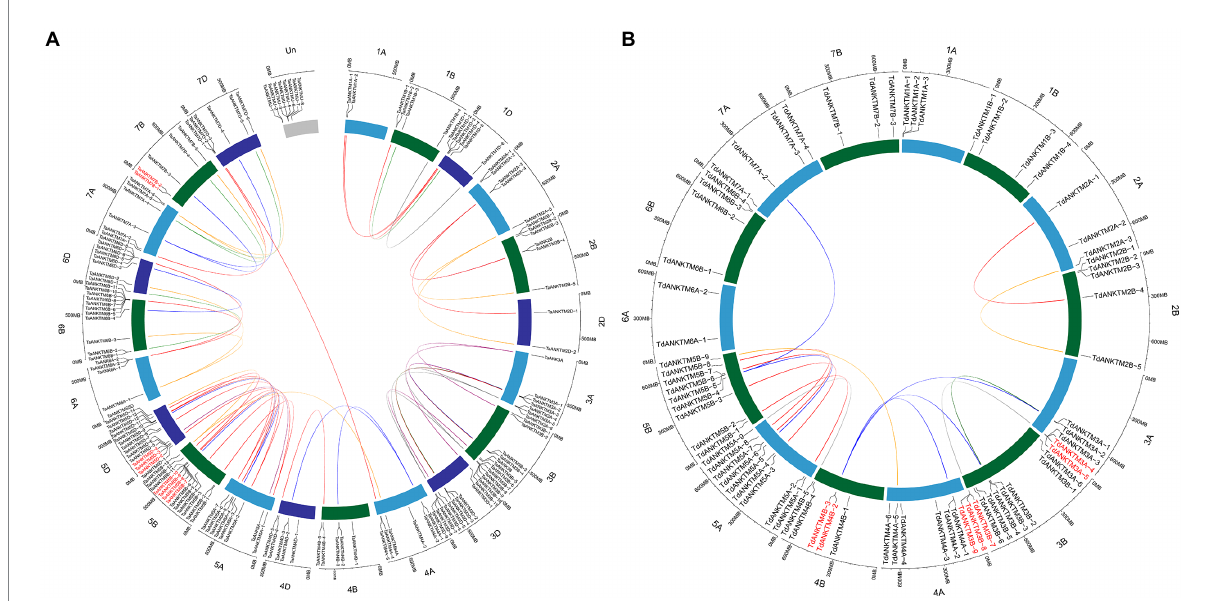
FIGURE 2 Homologous gene pairs, tandem duplication and location of ANKTM genes in wheat and T. dicoccoides genomes. All ANKTM genes were mapped to their respective loci in the wheat (A) and T. dicoccoides (B) genome in a circular diagram using shinyCircos. Homologous genes were inferred by TGT and linked with specific colors. Tandem duplication was analyzed by MCScanX, and the genes of red font indicated these genes were produced by tandem duplications. Subgenomes A and B are indicated by light blue and dark green, respectively; subgenomes D of wheat is indicated by dark